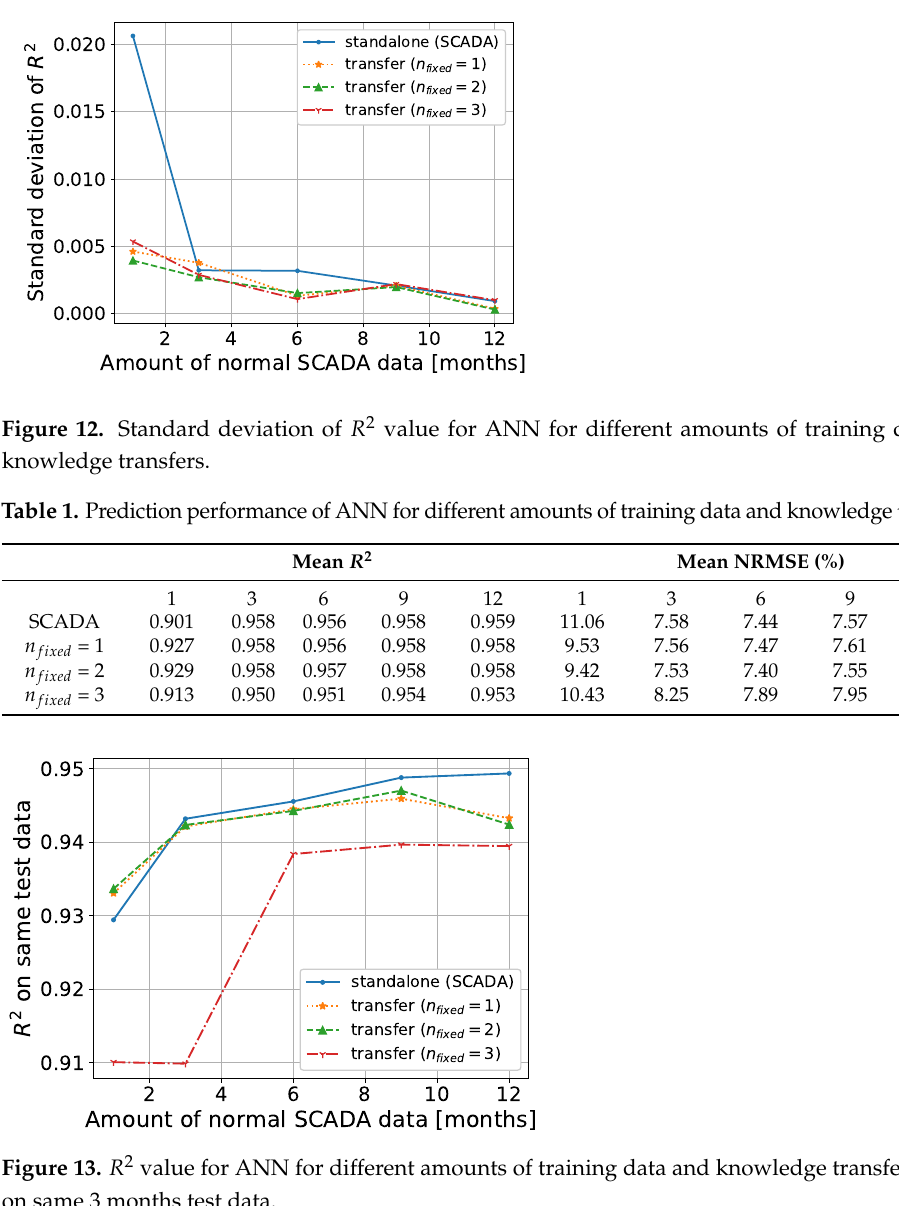
Figure 11. Average R 2 value for ANN for different amounts of training data and knowledge transfers.